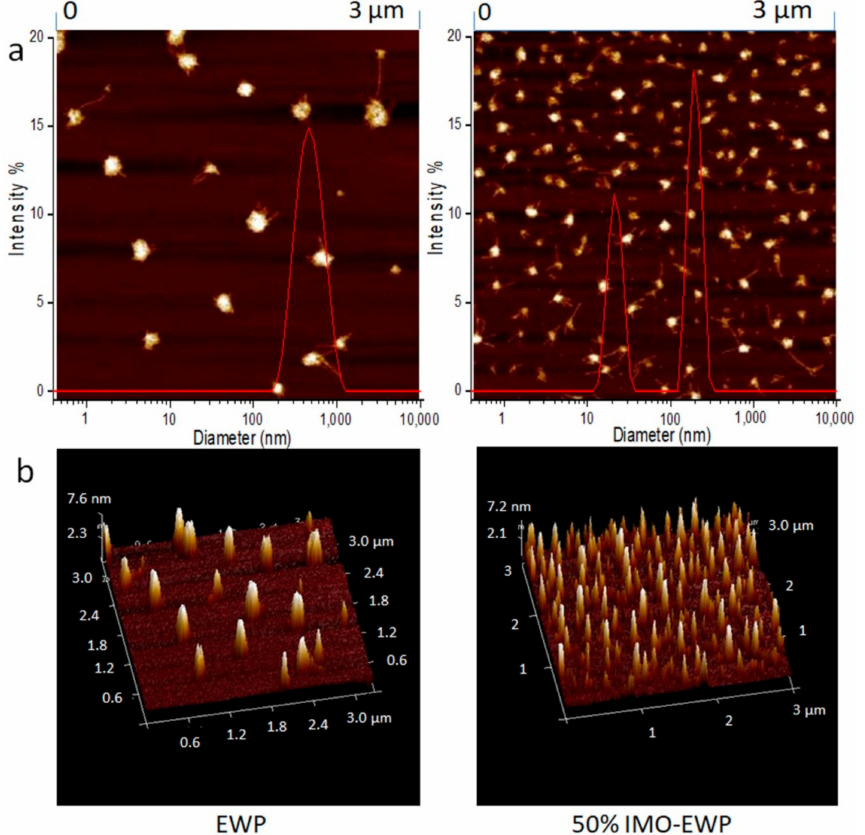
Figure 7. Atomic force microscope (AFM) images and particle diameter distributions of heat-induced particles from EWP and 50% IMO-EWP conjugate. 2D images and particle diameter distributions ( a ); 3D images ( b